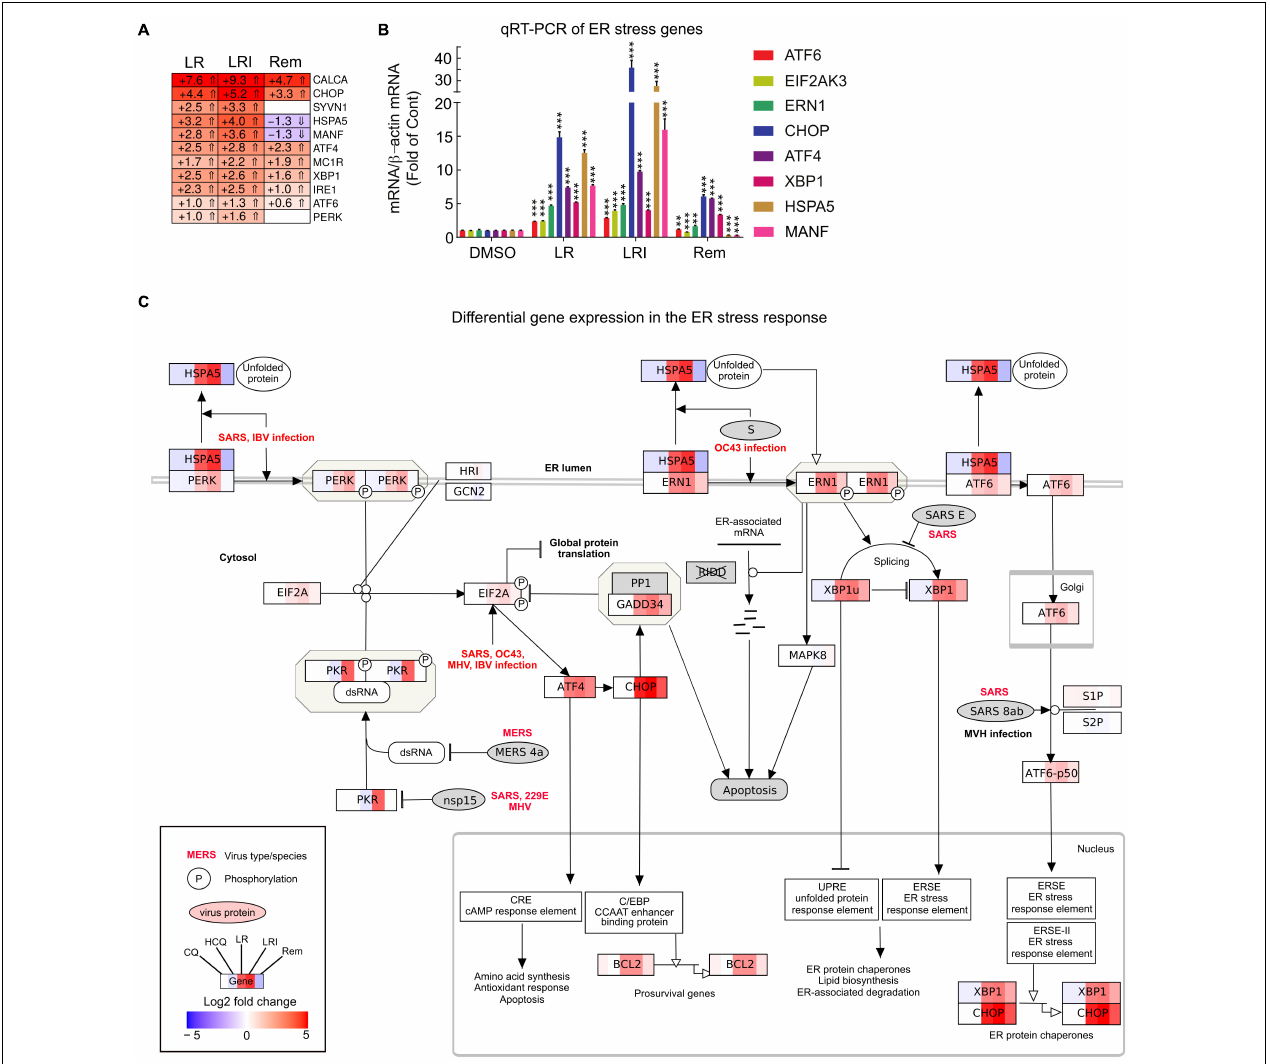
FIGURE 4 | Expression of ER stress associated genes with LR, LRI, and Rem treatment. (A) Clustered heatmap of a panel of selected ER stress associated genes showing the calculated Log2 fold change after LR, LRI, and Rem treatment compared to control (FDR ≤ 0.05, | Log2 fold change| ≥ 0.5). LR: lopinavir/ritonavir; LRI: lopinavir/ritonavir + interferon- β ; Rem: remdesivir. (B) Gene expression was determined by qRT-PCR using RNA from hiPSC-CMs plated at 1 × 10 6 cells/well on 6-well culture dishes and treated for 24 h with LR, LRI, Rem, or vehicle control (DMSO). (C) Mapping of differential gene expression data onto a representation of the ER stress response pathway. Each box contains a color-coded representation of the Log2 fold change of the gene in the following sample order: CQ, HCQ, LR, LRI, Rem. CQ: chloroquine; HCQ: hydroxychloroquine. Two-group comparisons were performed using Student’s two-tailed t -test. Data are represented as mean with all error bars indicating ± s.e.m. ** P ≤ 0.01 and *** P ≤ 0.001 compared to DMSO